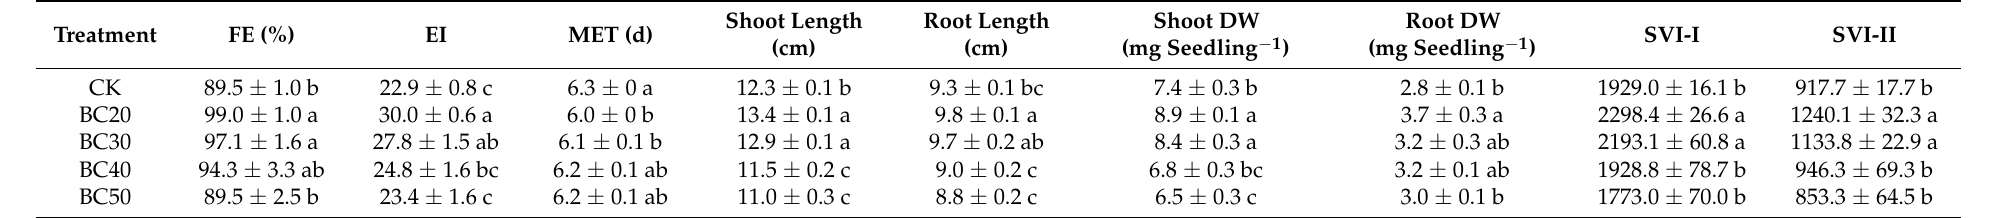
Table 2. Effect of different content of BC coating on WDR seed germination and seedling growth under growth chamber experiment.